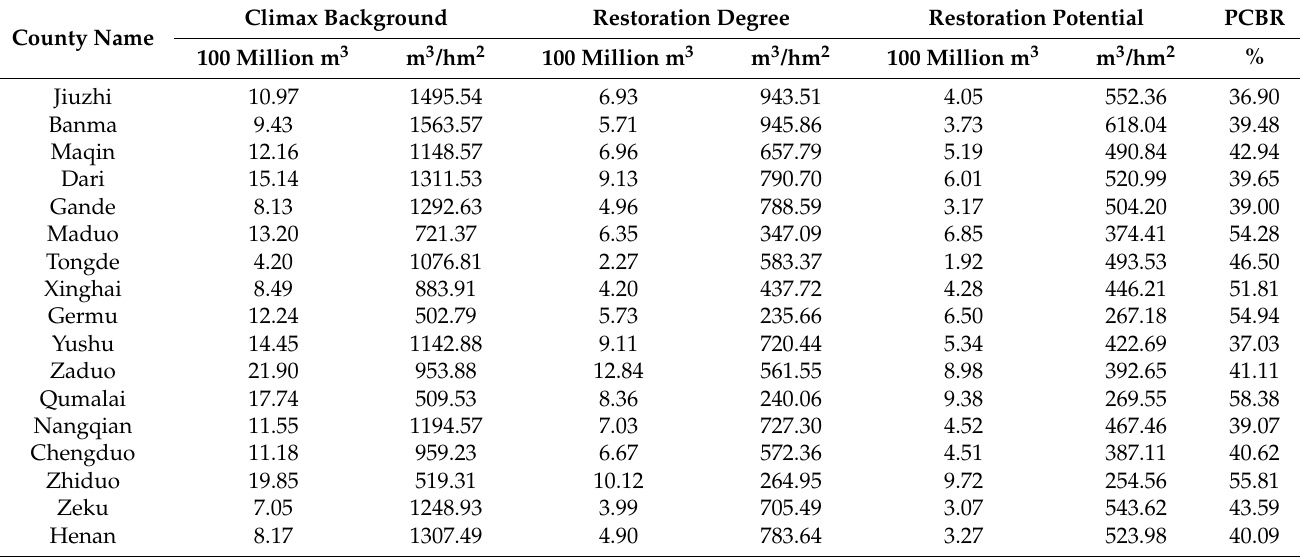
Figure 6. Spatial distribution of average annual water retention ( a ), change trend ( b ), significant trends ( c ) and percentage ( d ) of forest and grass ecosystems in the TRHR from 2000 to 2019. Table 3. Statistical table of climax background, restoration degree, restoration potential, and PCBR of WR in TRHR’s